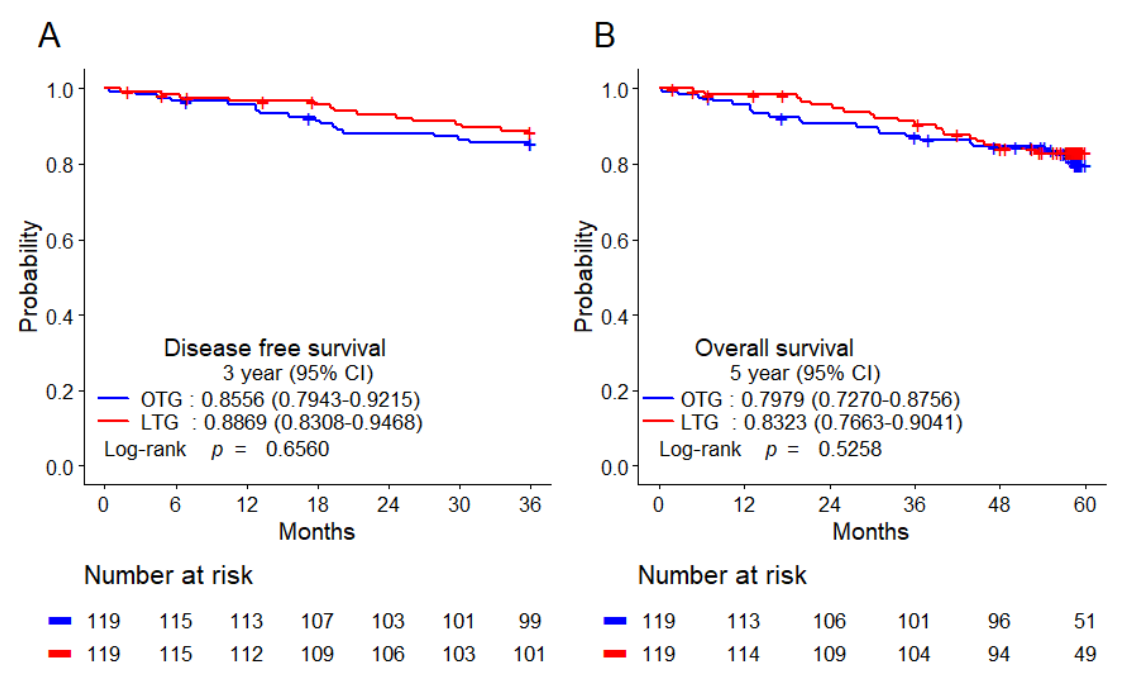
Figure 1. Kaplan − Meier survival analysis of 3-year DFS ( A ) and 5-year OS ( B ) after PSM. CI, confidence interval; DFS, disease-free survival; OS, overall survival; PSM, propensity score matching.